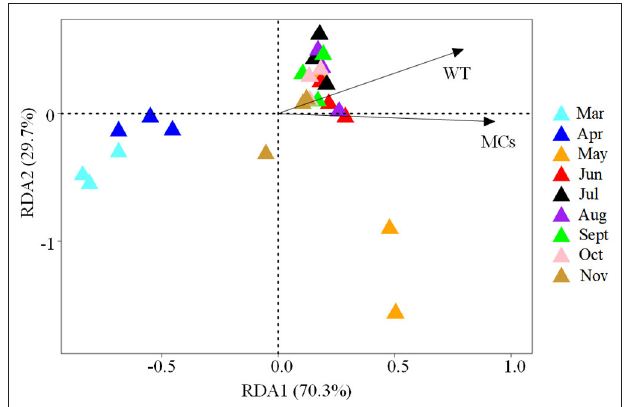
FIGURE 5 | The biplot of the first two axes of the RDA analysis for the significant environmental factors associated with gut microbial community variation.